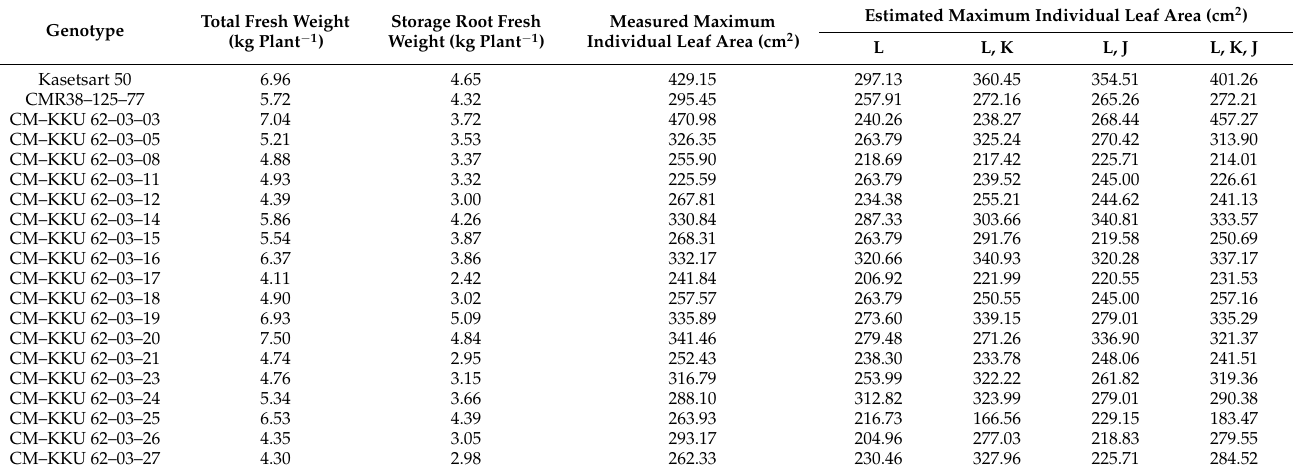
Table A1. Total fresh weight, storage root fresh weight, measured maximum individual leaf area, and estimated maximum individual leaf area based on the function of the length of the central lobe (L), the product of length and width (K), and the product of the length and number of lobes (J) for the Kasetsart 50 and CMR38–125–77 genotypes and 60 segregating